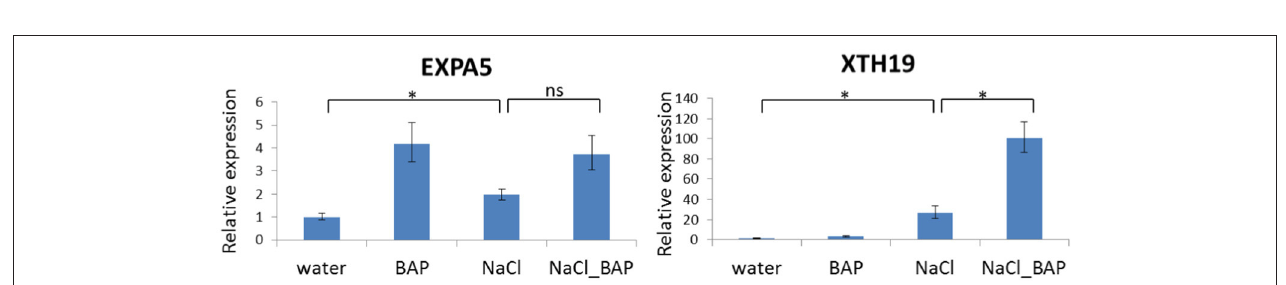
FIGURE 14 | Effect of CK on differential expression of the EXPA5 and XTH19 genes under salinity stress. Arabidopsis w.t. plants were grown for 30 days in optimal conditions and then leaves were detached and exposed to BAP 10 µ m, 120mM NaCl, or salt plus BAP for 24h. Controls were detached leaves in water. Three samples were collected from the controls and stressed leaves. Expression of each gene in w.t. control plants was used for comparison (relative expression = 1). Horizontal brackets denote t -test with significance of P < 0.05 (*, statistical significance; ns, no